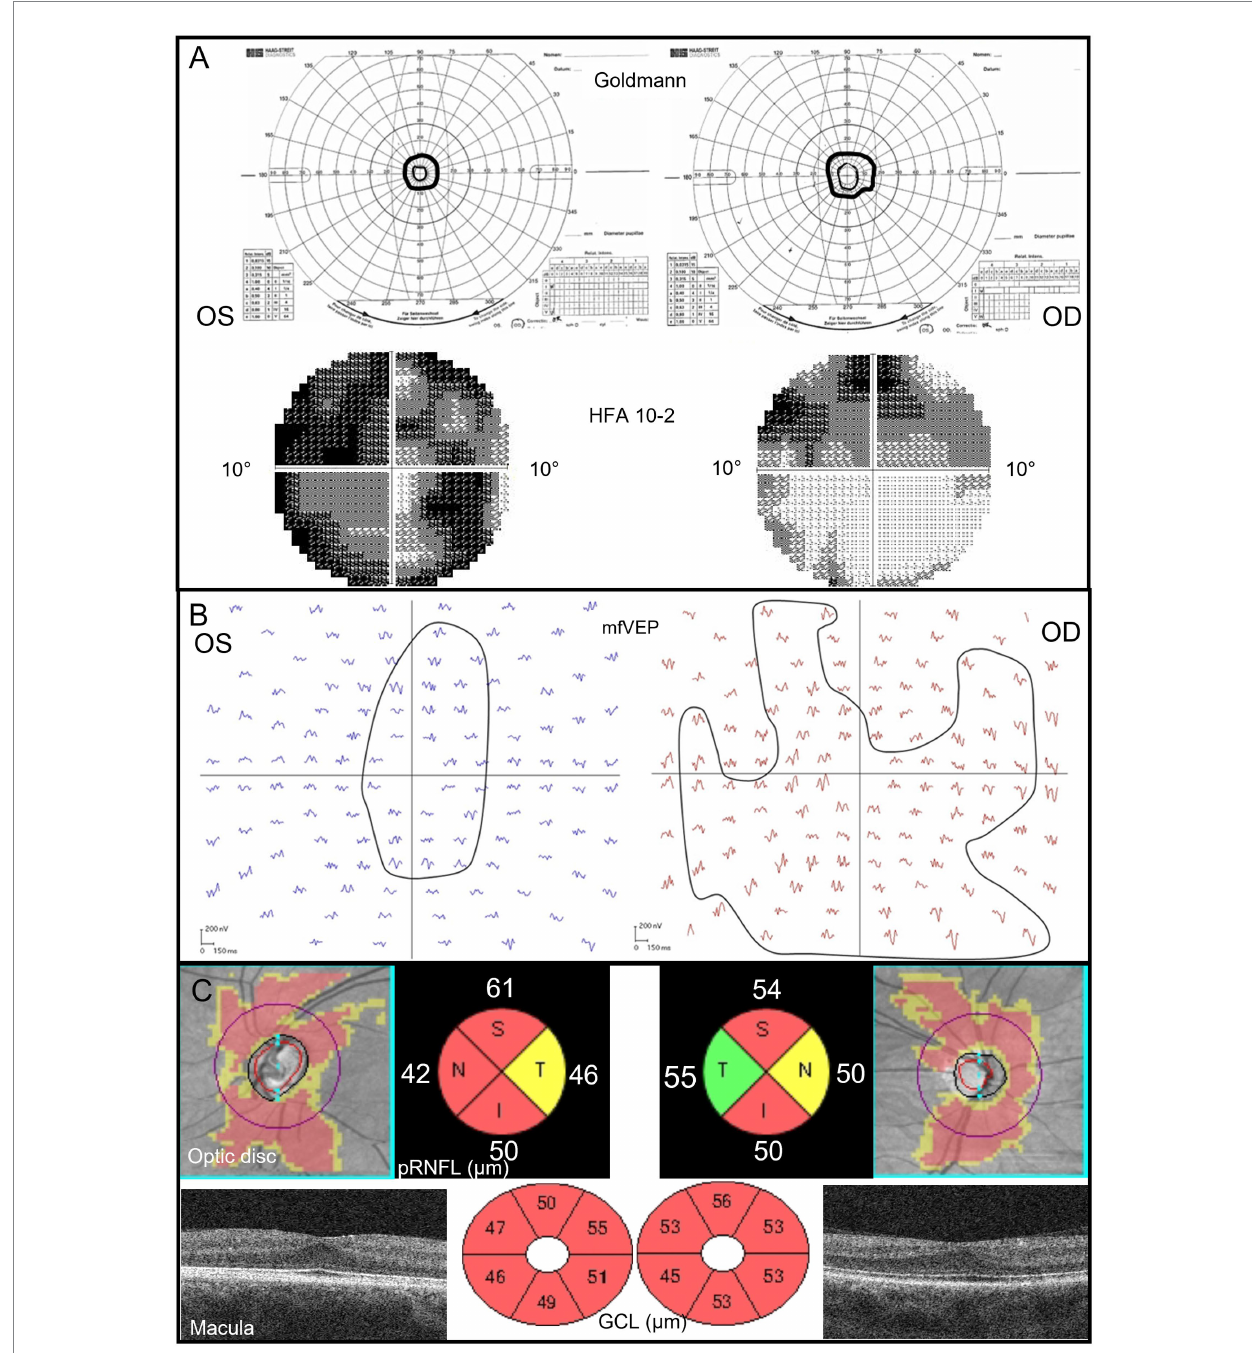
FIGURE 1 (A) Goldmann perimetry shows completely constricted visual fields (tunnel vision). HFA 10–2 shows a marked reduction, especially in the left eye, with the best function in the lower parts of the central field of the right eye. (B) MfVEP responses from the left and right eye describe the cortical response correlating to the central 20–25-degree VF. Amplitudes with the best signal-to-noise ratio are more concentrically constricted in the left eye, and the amplitudes are generally lower in this eye than the amplitudes from the right eye. (C) OCT images are color-coded according to red = outside normal limits, yellow = borderline, and green = within the limits of the reference database. All retinal thickness values are in μ m. The pRNFL topography shows a generally thin peripapillary nerve fiber layer with some sparing in the temporal quadrants in the right eye. The macular GCL topography indicates a very thin layer in both eyes and is most pronounced in the left eye. The foveal pit is shallow in both eyes and shows signs of inhibited migration of the inner retinal layers centrally. OS, left eye; OD, right eye; S, superior; N, nasal; I, inferior; T, temporal; pRNFL, peripapillary retinal nerve fiber layer; GCL, ganglion cell + inner plexiform layer; and HFA, humphrey field